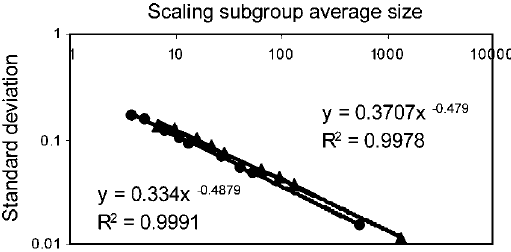
Figure 4. Size effect of scaling subgroup on the FhomEstimator accuracy. Two sets of protein pairs of fruit fly and human Swiss-Prot proteins were estimated to have Fhom of 52% and 10%. Both alignment sets were used separately for the sample size simulation. Each set of pairs was divided into the observed subgroups. The proportions of the observed subgroups were used for simulating observed distributions of 9 different sample sizes ranging from 10,000 to 75. Each simulation was repeated 1000 times, and the average Fhom, Fhom standard deviation, and the average size of the scaling subgroup were taken. The power regression curves of the 52% homologs (lower left curve) and the 10% homologs (upper right curve) describe the correlation between the mean size of the scaling subgroup and the standard deviation of Fhom , with high coefficients of determination.